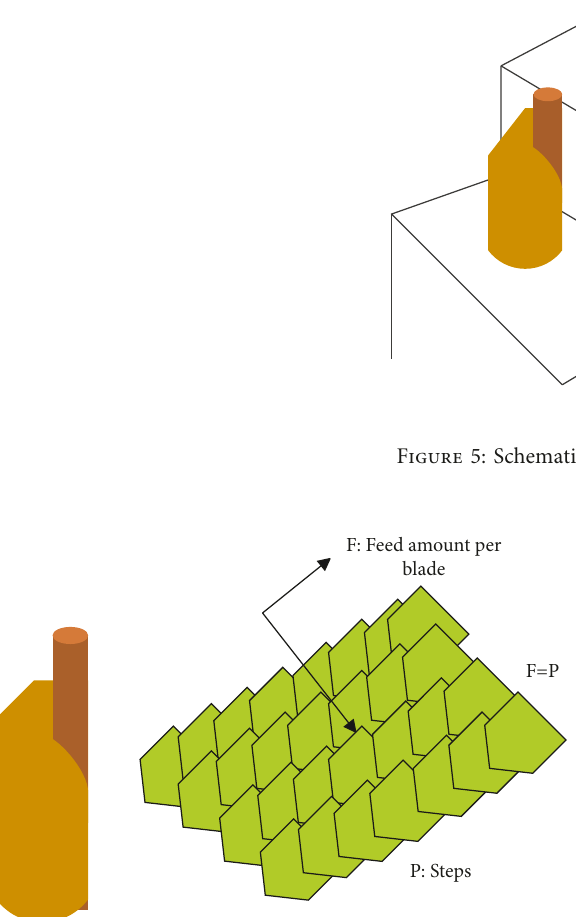
Figure 6: FP milling